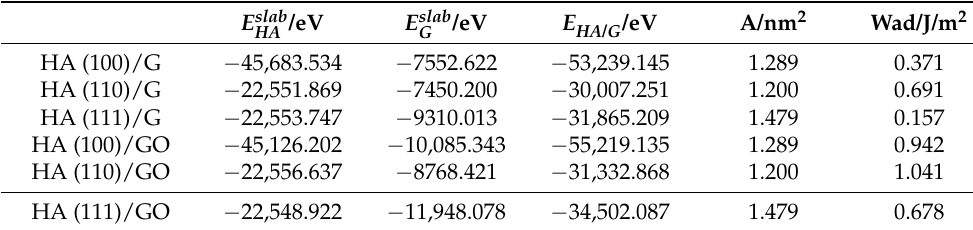
Table 1. Related index values and calculation results of interface adhesion work for each